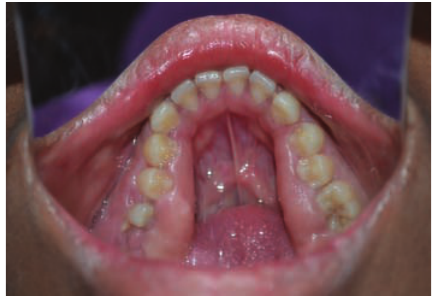
Figure 5: Clinical picture showing prominent gingival enlargement in posterior region.